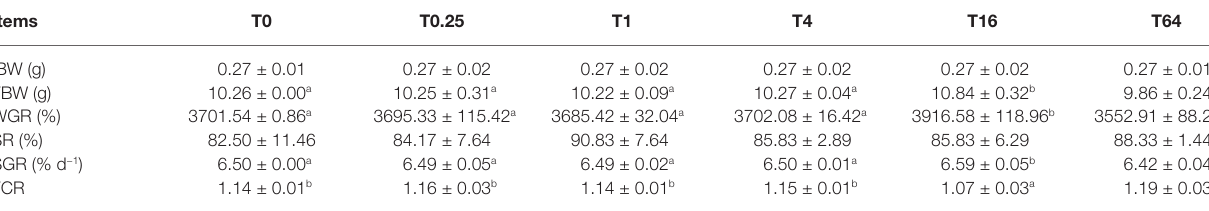
TABLE 3 | Effects of dietary TWS119 on growth performance of Litopenaeus vannamei . Items